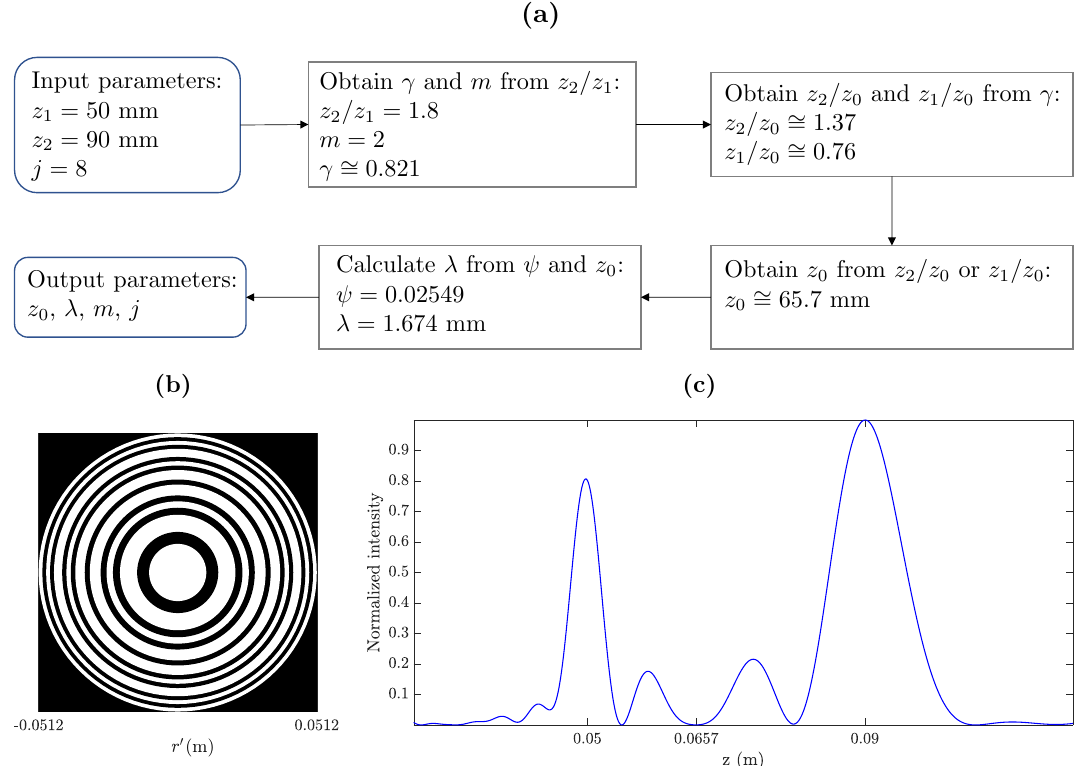
Figure 6. Lens design example with z 1 = 50 mm and z 2 = 90 mm: ( a ) Design procedure flow diagram, ( b ) resulting MbZP lens, and ( c ) numerically computed focusing